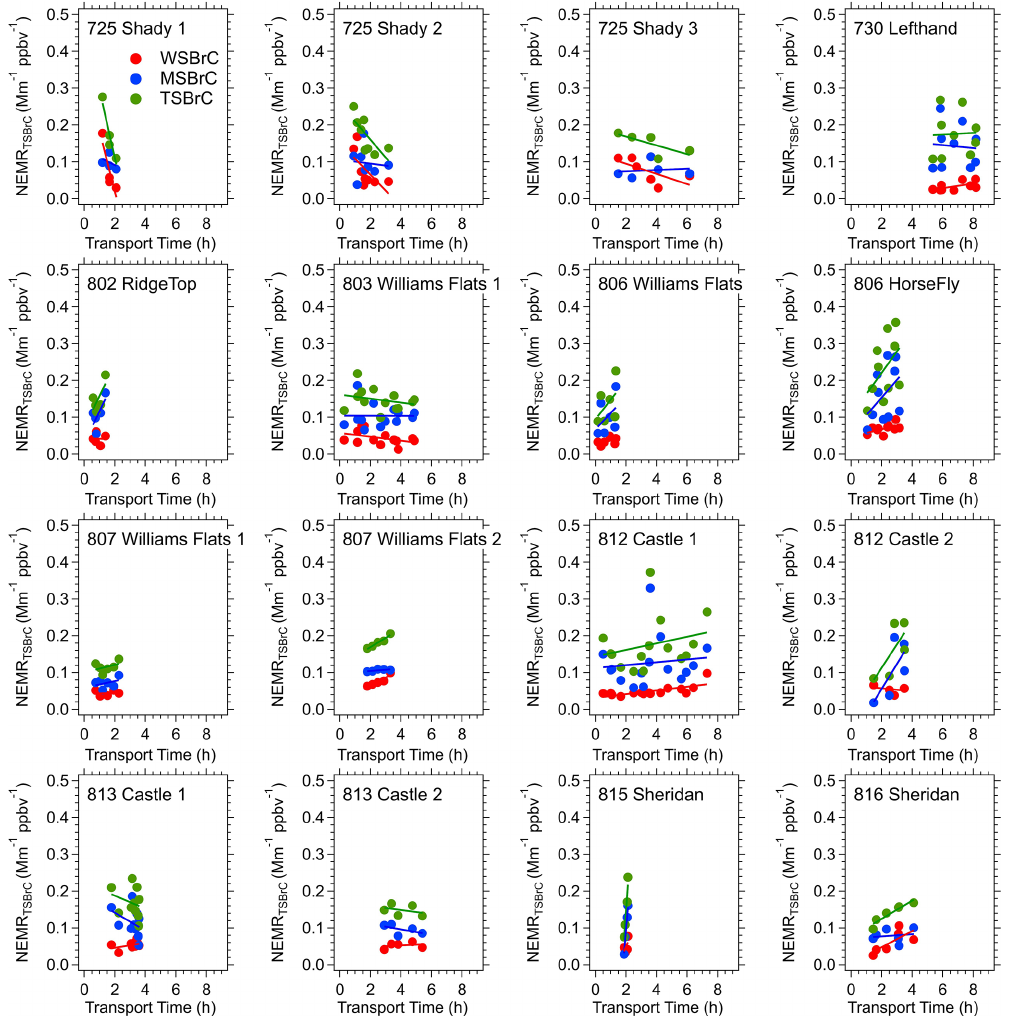
Figure 9. Evolution of water, methanol and total soluble forms of BrC relative to CO (NEMR BrC = (cid:49) BrC /(cid:49) CO) within each of the various smoke plumes investigated in detail during FIREX-AQ. All of these data on one plot are shown in Fig. 8. Each data point is one plume transect (filter sample). Red data points are WS BrC, blue MS BrC and green TS BrC, which is the sum of the red and the blue. Linear fits are included with the